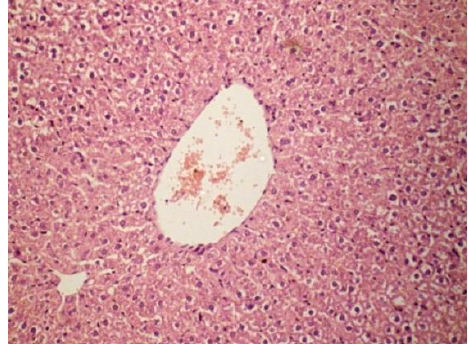
Fig 5. Rat liver. SHR rat control group. Hydropic swell- ing of hepatocytes and hydropic vacuolation. Hematoxy- lin and eosin staining. Eye. 10×. Lens.